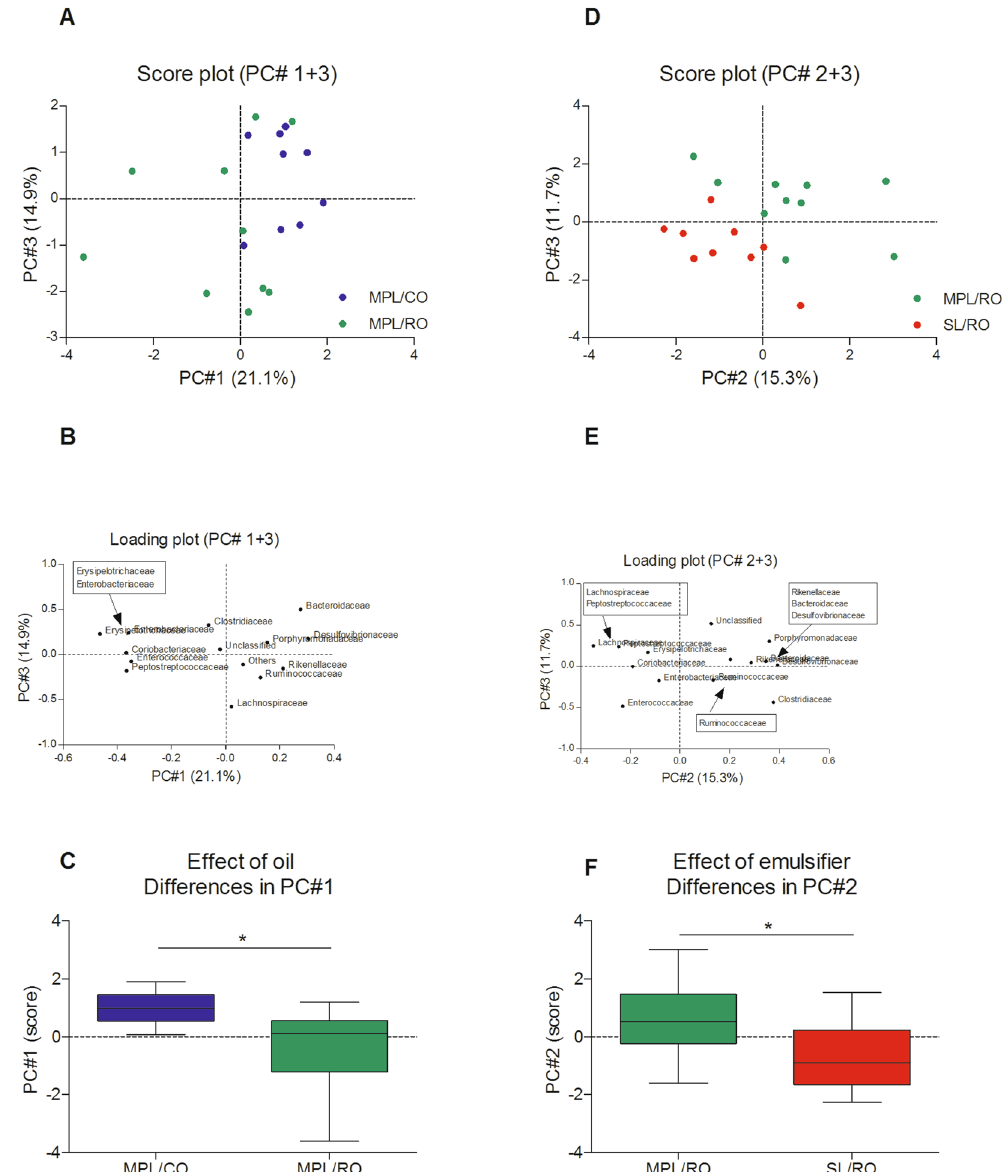
Figure 3. Effect of oil (left) and type of emulsifier (right) on the bacterial family composition in cecum as assessed by Principal Component Analysis. Score-plots ( A and D ), Loading plots ( B and E ), and differences in PC1 for the oil effect ( C ) and PC2 for the emulsifier effect ( F ) calculated using an unpaired t-test with Welch’s correction. Asterisks indicate significant differences ( * p < 0.05). PC: Principal Component, MPL: